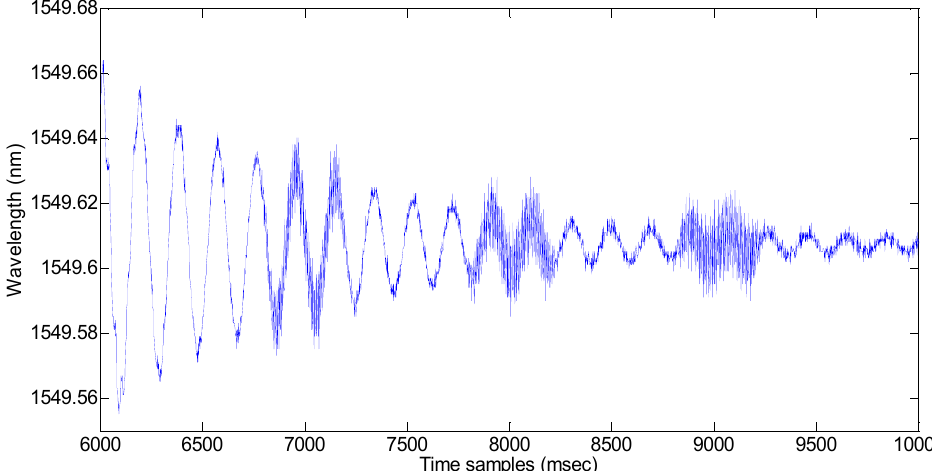
Figure 6. Time varying data of central wavelength of FBG, showing that the damped oscillation of the sensing beam behaves as a cantilever. The pulsed vibrations from the phone are superposed as periodic high frequency waves. The x-axis scale is in samples of time (ms).